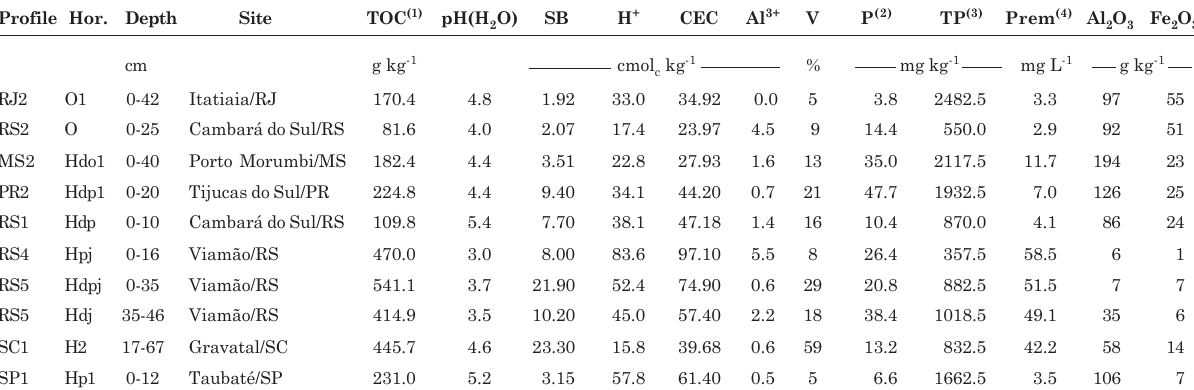
Table 1. General, morphological, and chemical characteristics of Histic O and H horizon samples